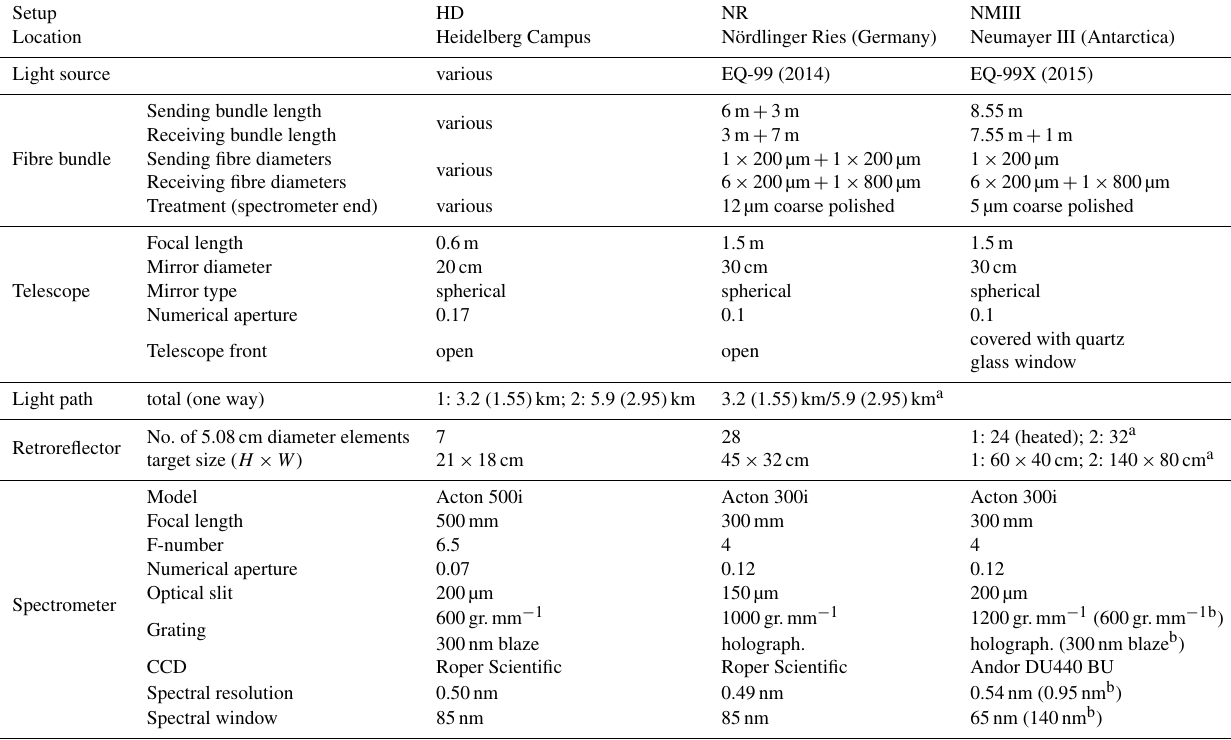
Table 1. Overview of the different LP-DOAS setups used in this study.